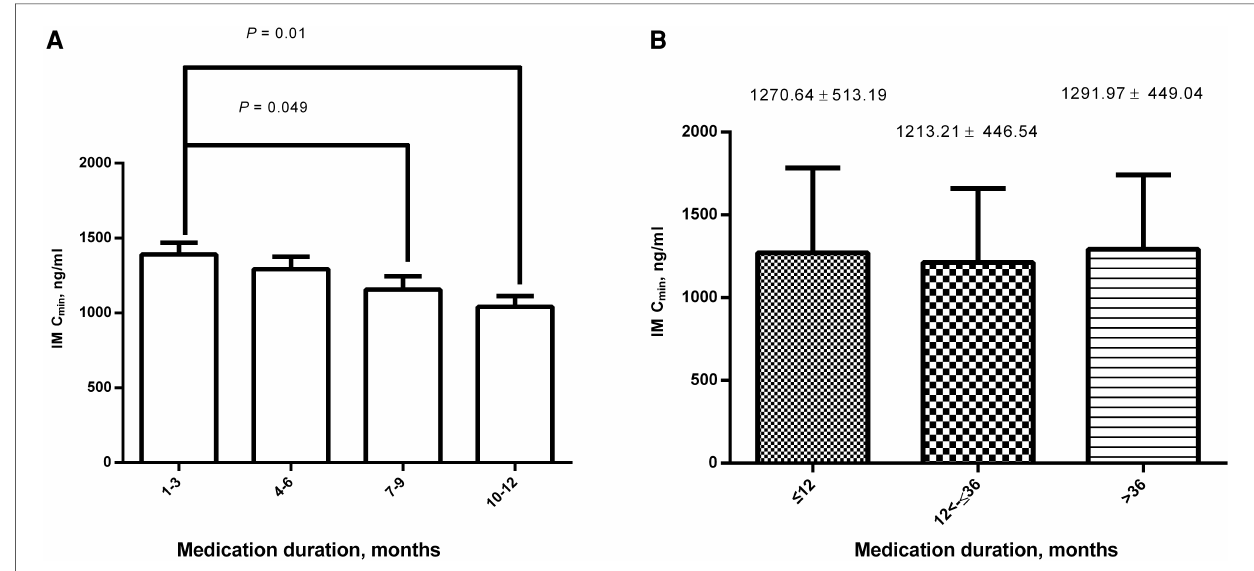
FIGURE 2 Comparison of IM C min among different medication durations. ( A ) There were statistically signi fi cant differences between 1 – 3 months, 7 – 9 months, and 10 – 12 months; ( B ) There were no statistically signi fi cant differences between ≤ 12, 12< – ≤ 36, and >36 months. IM, imatinib; C min , plasma trough